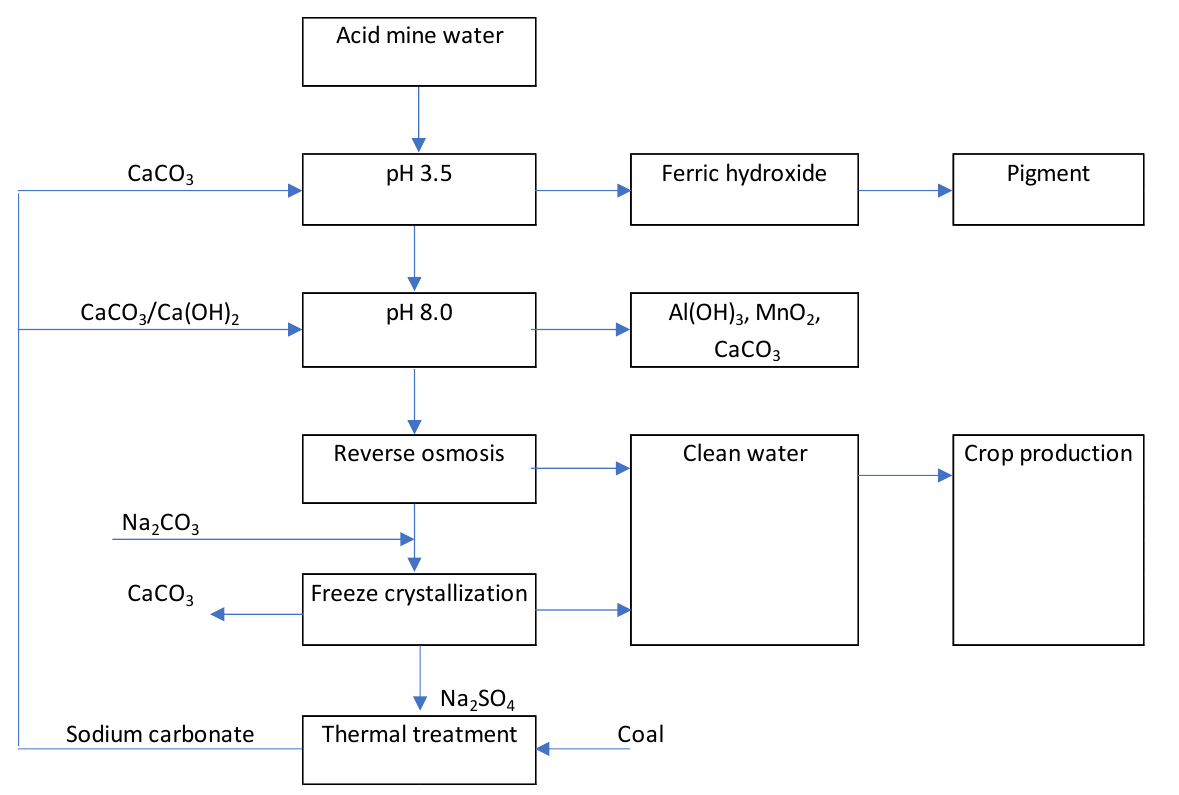
Figure 1. Ideal solution for mine water treatment.